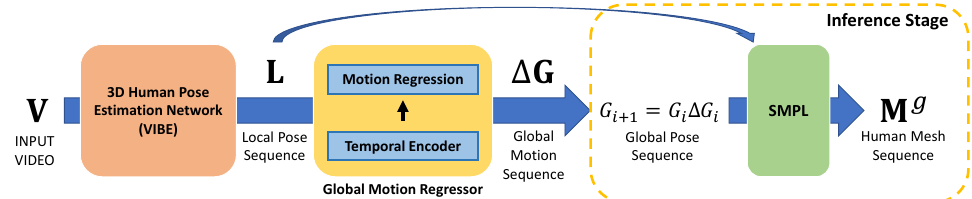
Figure 3. Overall framework of the proposed method. Given an input video, the existing 3D human pose estimation network outputs a local human pose sequence. The proposed global motion regressor generates a global motion sequence from the local pose sequence. In the inference stage, the global motion is accumulated into a global pose, and finally, the SMPL reconstructs a human mesh sequence with the global pose defined in the world coordinate